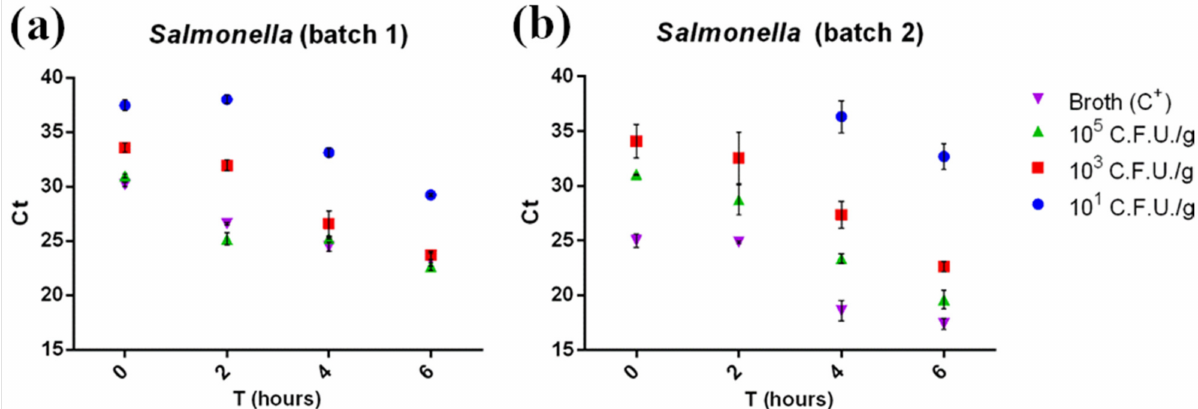
Figure 3. Ct of the first batch ( a ) and the second batch ( b ) of minced chicken meat samples contaminated with Salmonella plotted against related enrichment times (0, 2, 4, and 6 h). Ct was inversely correlated with enrichment time and bacterial concentration. No amplification was detected at the 10 1 CFU/g contamination level T0 and T2 samples in batch 2. Measurements were performed on two separate batches of minced chicken meat in triplicate. The mean ± SD of each measurement is shown. The full dataset can be found in Table